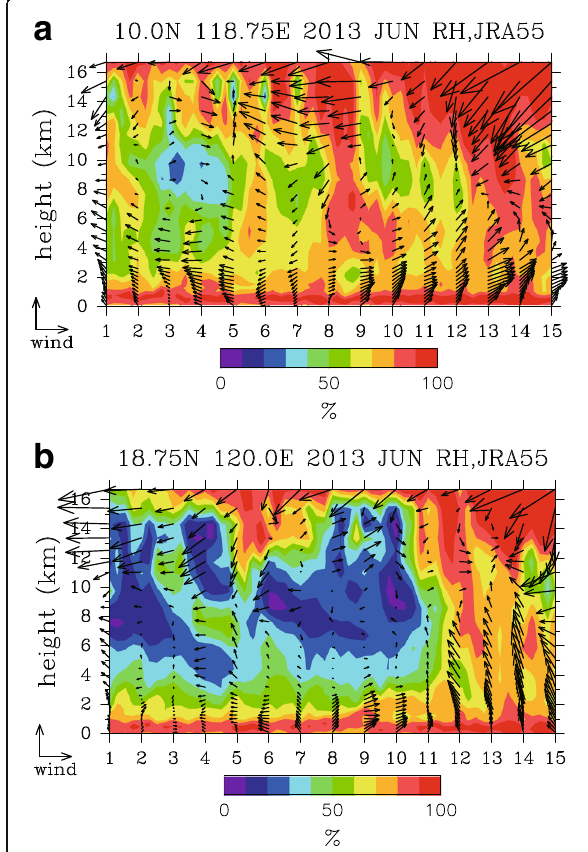
Fig. 9 Atmospheric profile by JRA55 during June 1 – 15, 2013. Same as Fig. 8 but for JRA55 relative humidity and wind at a 10.0° N, 118.75° E (including Puerto Princesa) and b 18.75° N, 120.0° E (including